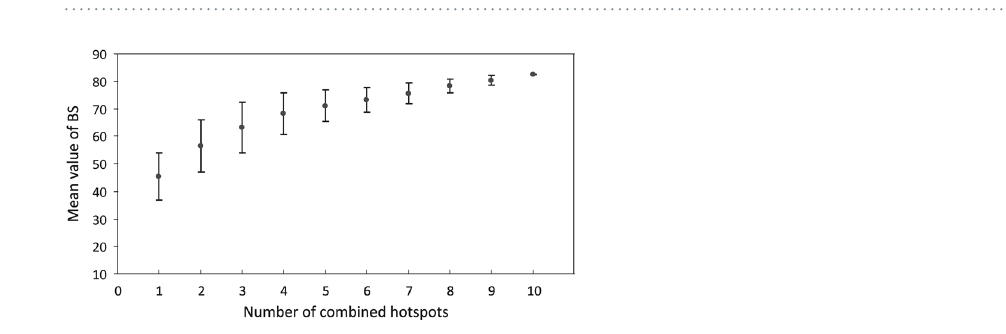
Figure 2. The sequence variability (%) and GC content among the 92 syntenic intergenic and intronic loci from Dendrobium plastomes. The red and green lines represent the sequence variability (%) and GC content of each locus, respectively. These syntenic loci are oriented according to their locations in the plastome. The top-ten syntenic intergenic and intronic loci with the highest sequence variability (%) in the tested Dendrobium plastomes were indicated with blue box.